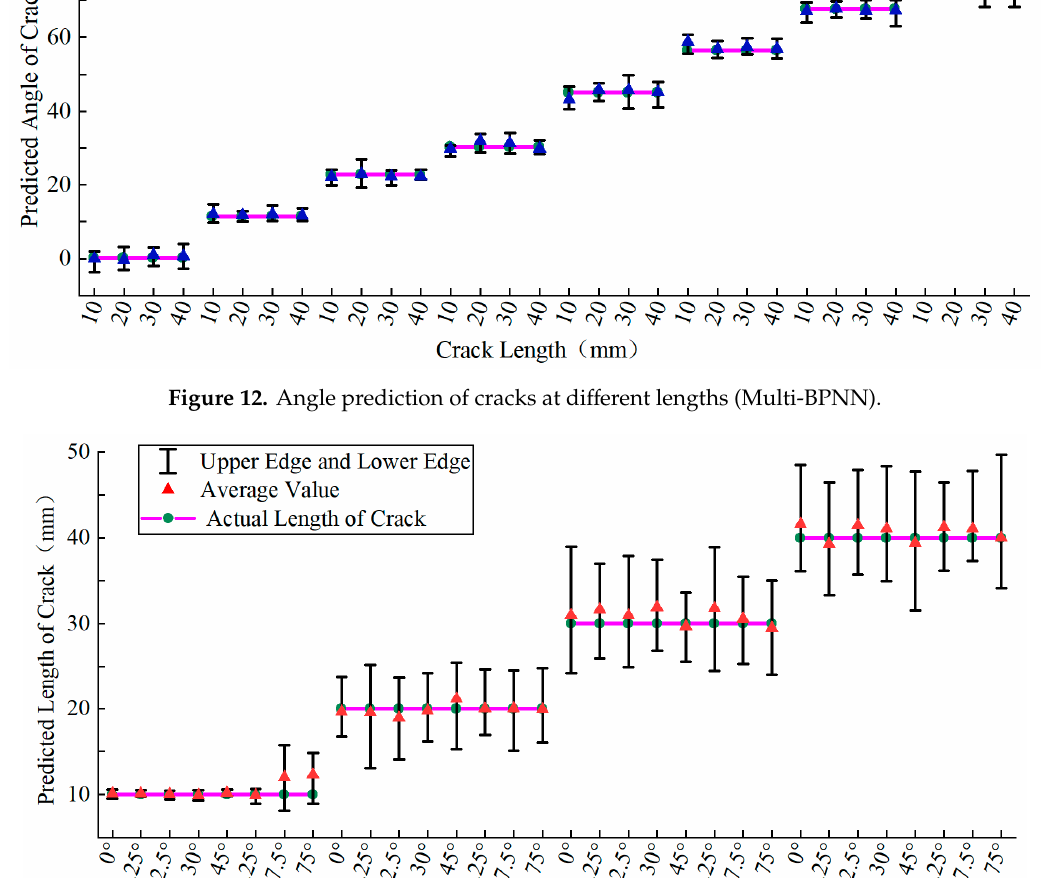
Figure 14. Angle prediction of cracks at different lengths (MIMO-BPNN). Table 2. Predicted deviation range of the mean. Predicted Parameter